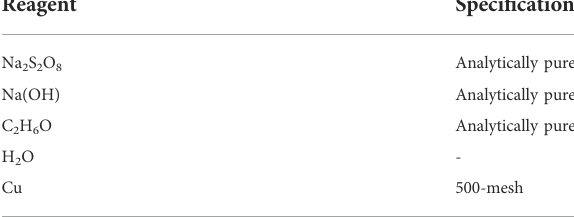
TABLE 1 Experimental reagents and substrates.